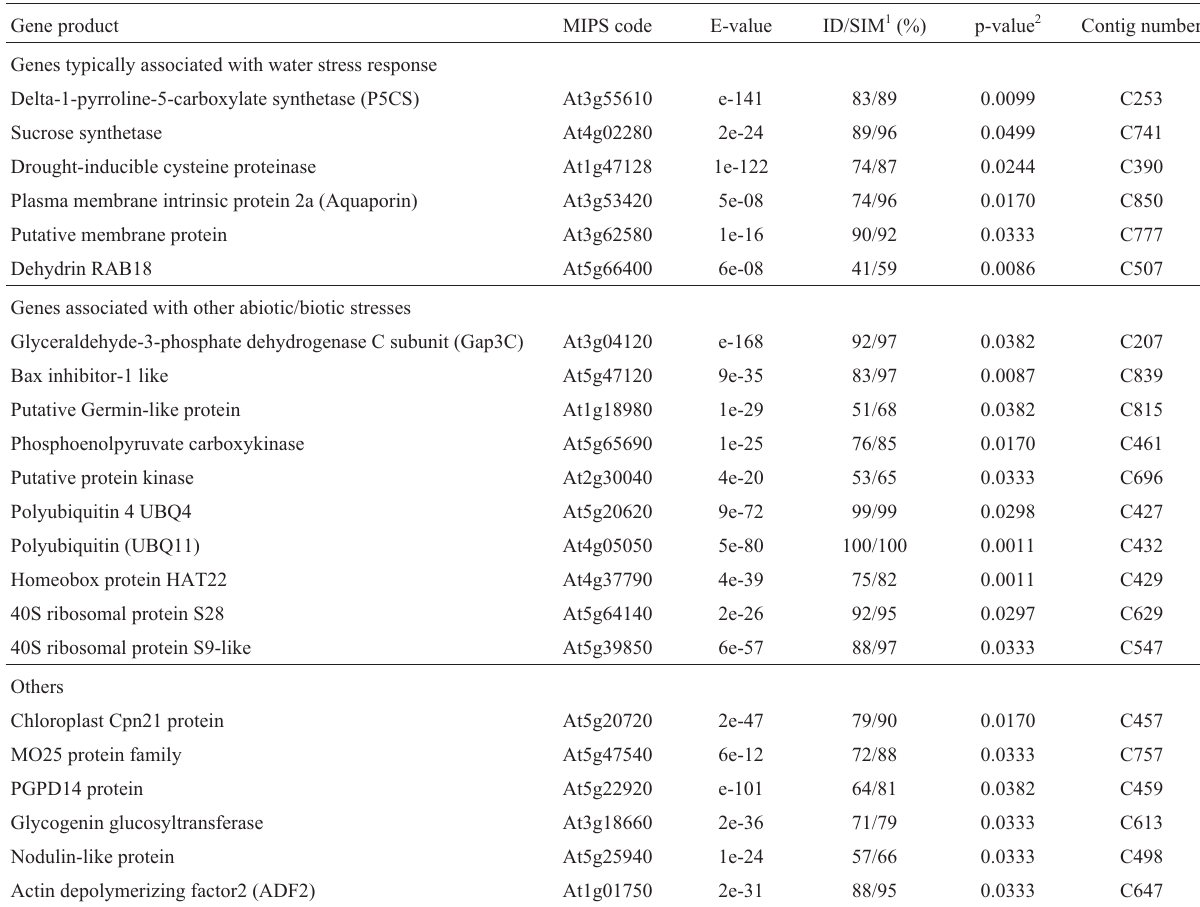
Table 1 - Up-regulated genes under water stress in Rangpur lime